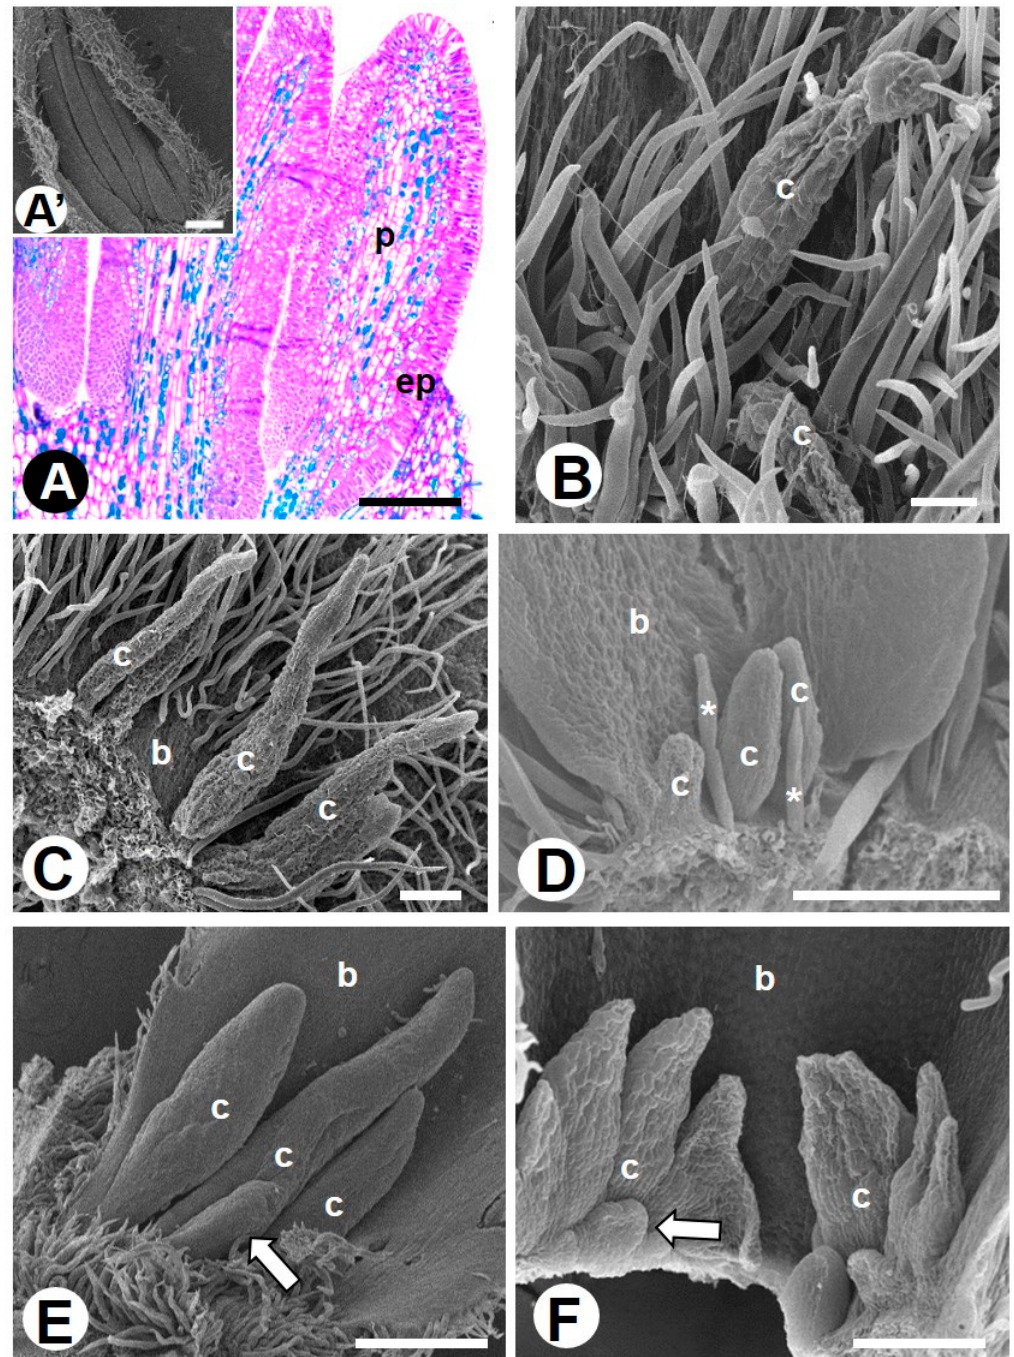
Figure 1. Colleters found in flowers of Rhamnaceae species. ( A’ , B – F ) = SEM, ( A ) = light microscopy (LM). ( A ) Surface view ( A’ ) and anatomy ( A ) of colleters in Colubrina glandulosa . Note the palisade-like epidermis and central parenchymatic axis containing phenolic idioblasts (greenish staining). Colleters are massive and fill the interior of the bracts. ( B ) Colleters of Gouania latifolia . ( C ) Colleters of Gouania virgata among the trichomes in the base of the bracts. ( D ) Wide colleters of Hovenia dulcis in the base of bracts. ( E ) Wide and small (arrow) colleters of Rhamnidium elaeocarpum similar to those found in C. glandulosa . ( F ) Wide and small (arrow) colleters of Sarcomphalus joazeiro . Symbols: b = bract, c = colleter, ep = epidermis, p = parenchymatic axis, * = trichomes, arrows = small colleter. Scale bars: ( A , D ), 200 μ m; ( A’ , E ), 500 μ m; ( B ), 50 μ m; ( C , F ), 100 μ m.